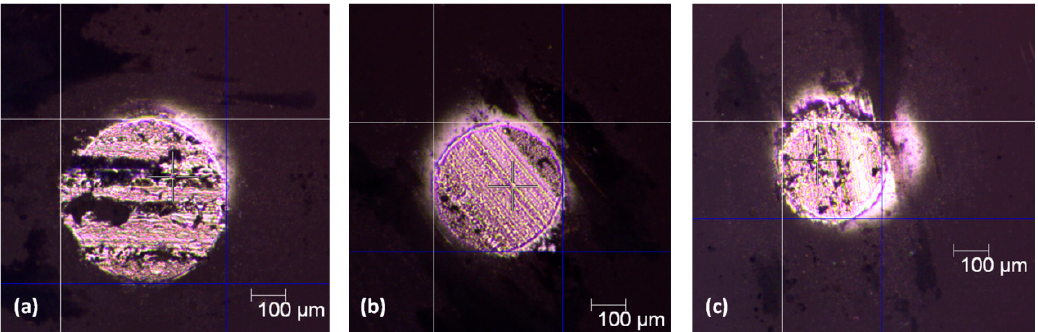
Figure 14. Wear of the counterpart–Al 2 O 3 ball after a dry sliding wear test against coatings deposited at substrate temperature of 350 °C, U B = − 100 V and nitrogen pressure. ( a ) 1 Pa; ( b ) 3 Pa; ( c ) 5 Pa.